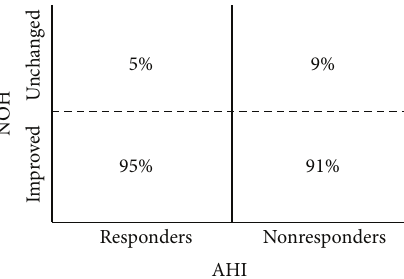
Figure 3: Comparison between postoperative NOH and postoper- ative